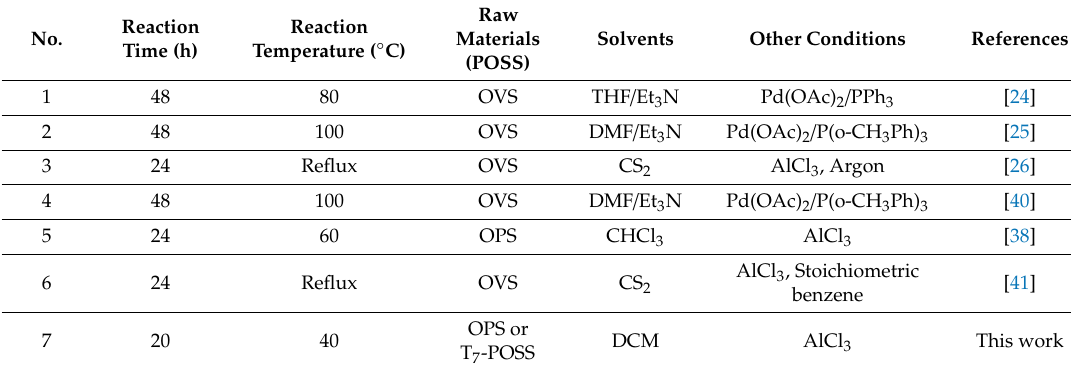
Table 4. Reaction condition